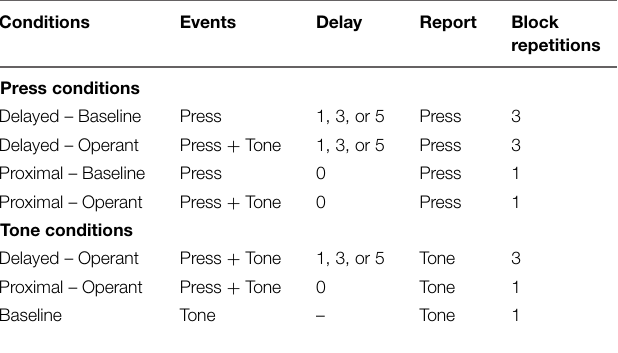
to notice the letter, when they had the intention to act, and then press when the same latter was presented again. In all operant conditions a tone were played 250 ms after the press. After a short random delay, participants had to report the “time” on the clock, when they either made the action or heard the